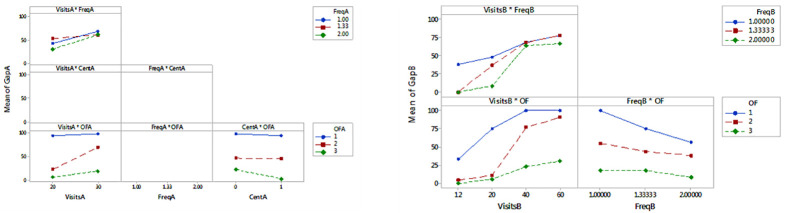
Interaction plots of significant factors.Groups A and B, respectively.